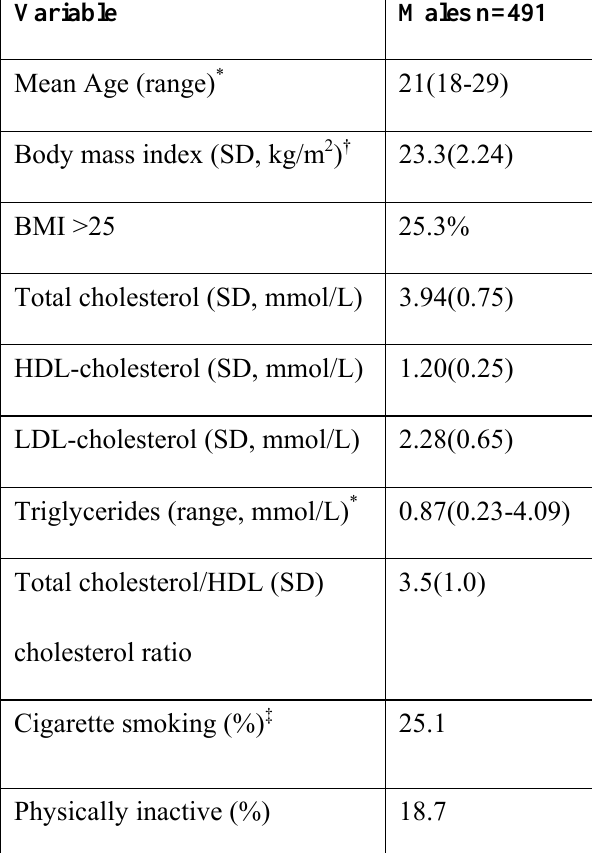
Table 1: Demographic and biochemical characteristics of study